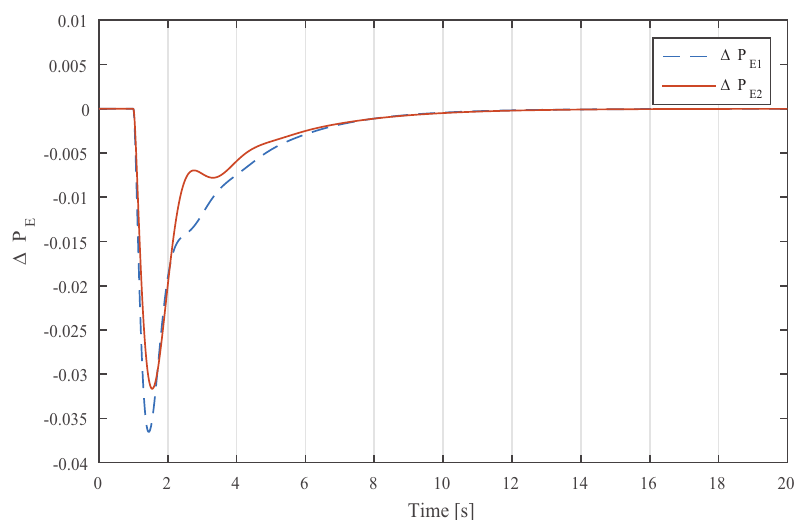
Figure 5. EVs’s responding curves of V2G system not subjected to